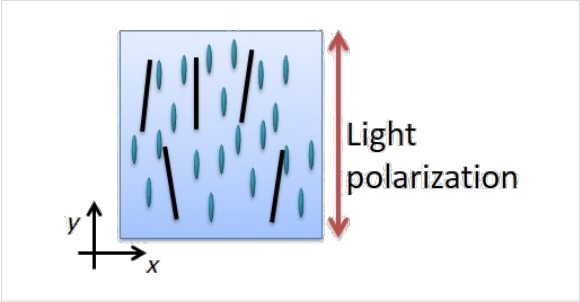
Figure 2: Linear polarized light direction for Raman measures at V = 0.